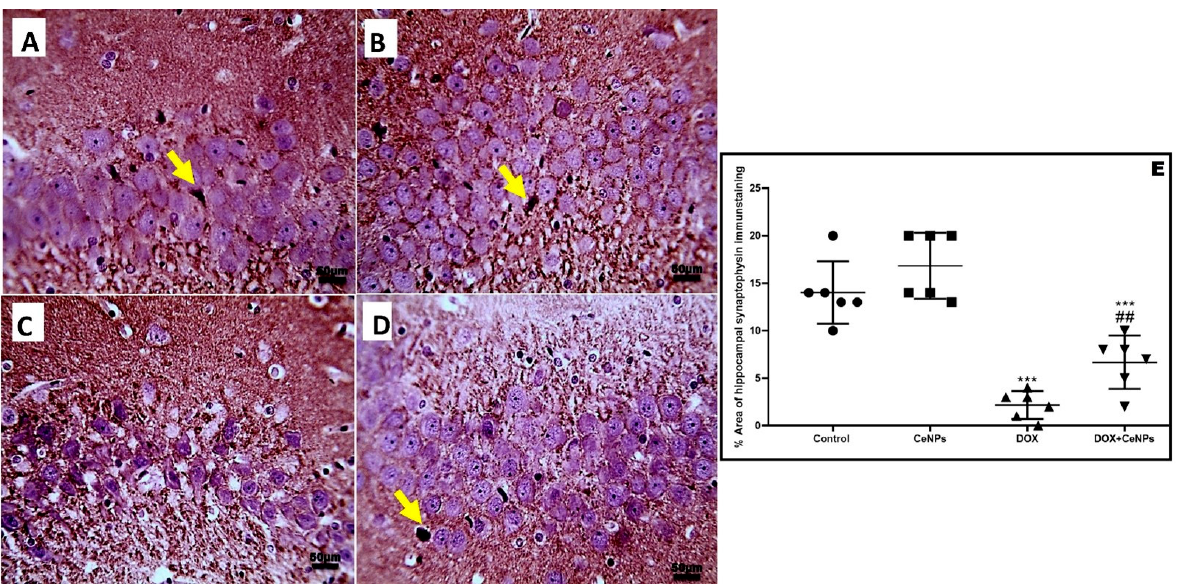
Figure 11. A. Microscopic pictures of immunostained sections of hippocampal sections against synaptophysin showing many positively brown stained neurons in pyramidal layer in CA3 region in both ( A , B ) control group and group which received CeNPs. ( C ) Hippocampal sections from the DOX group show negatively stained neurons. ( D ) Hippocampal sections from treated group DOX + CeNPs show increased numbers of positively brown stained neurons (yellow arrows). ( E ) Histogram of % area of immunostaining hippocampal synaptophysin. Values are shown as mean ± SD. One-way ANOVA with Tukey post hoc analysis was conducted. *** p < 0.001, ## p < 0.01. Magnification × 400. Scale bar = 50 µ m.